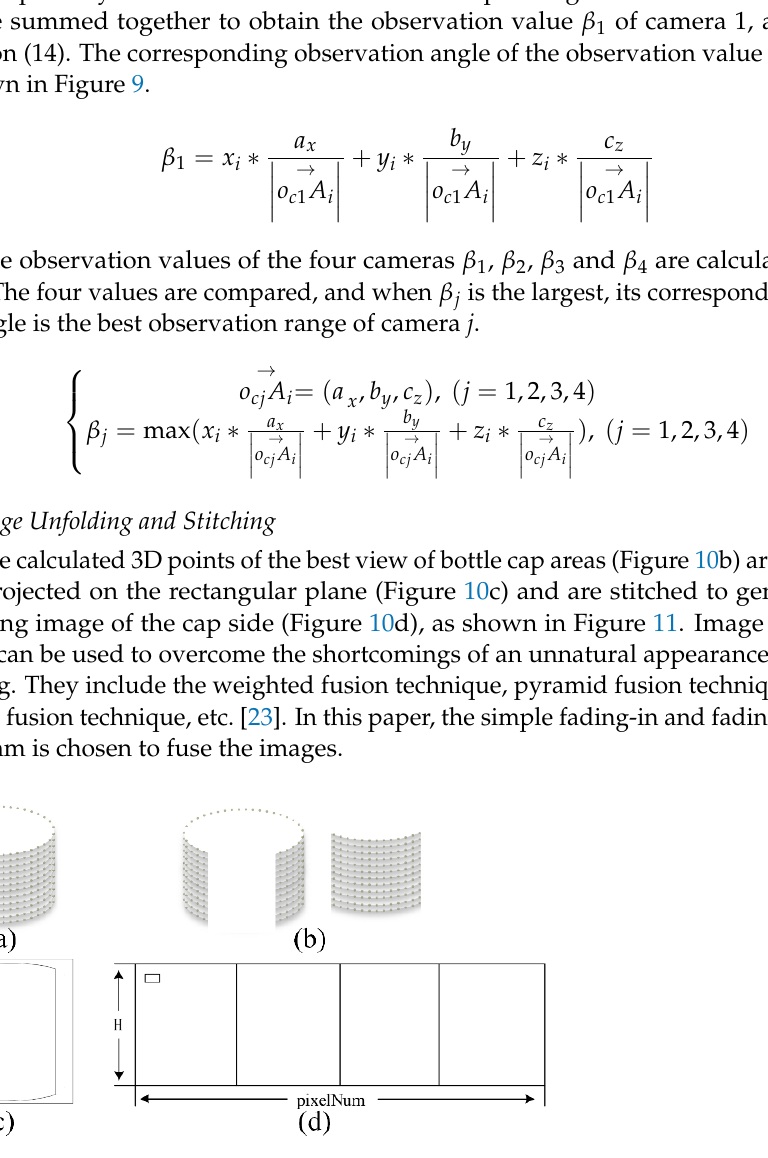
Figure 10. The unfolding and stitching flowchart of the cap: ( a ) The 3d model of the cap; ( b ) The best observation regions of the camera; ( c ) The cylindrical back-projection on the best observation regions of the camera; ( d ) The stitched result of the ( c ).